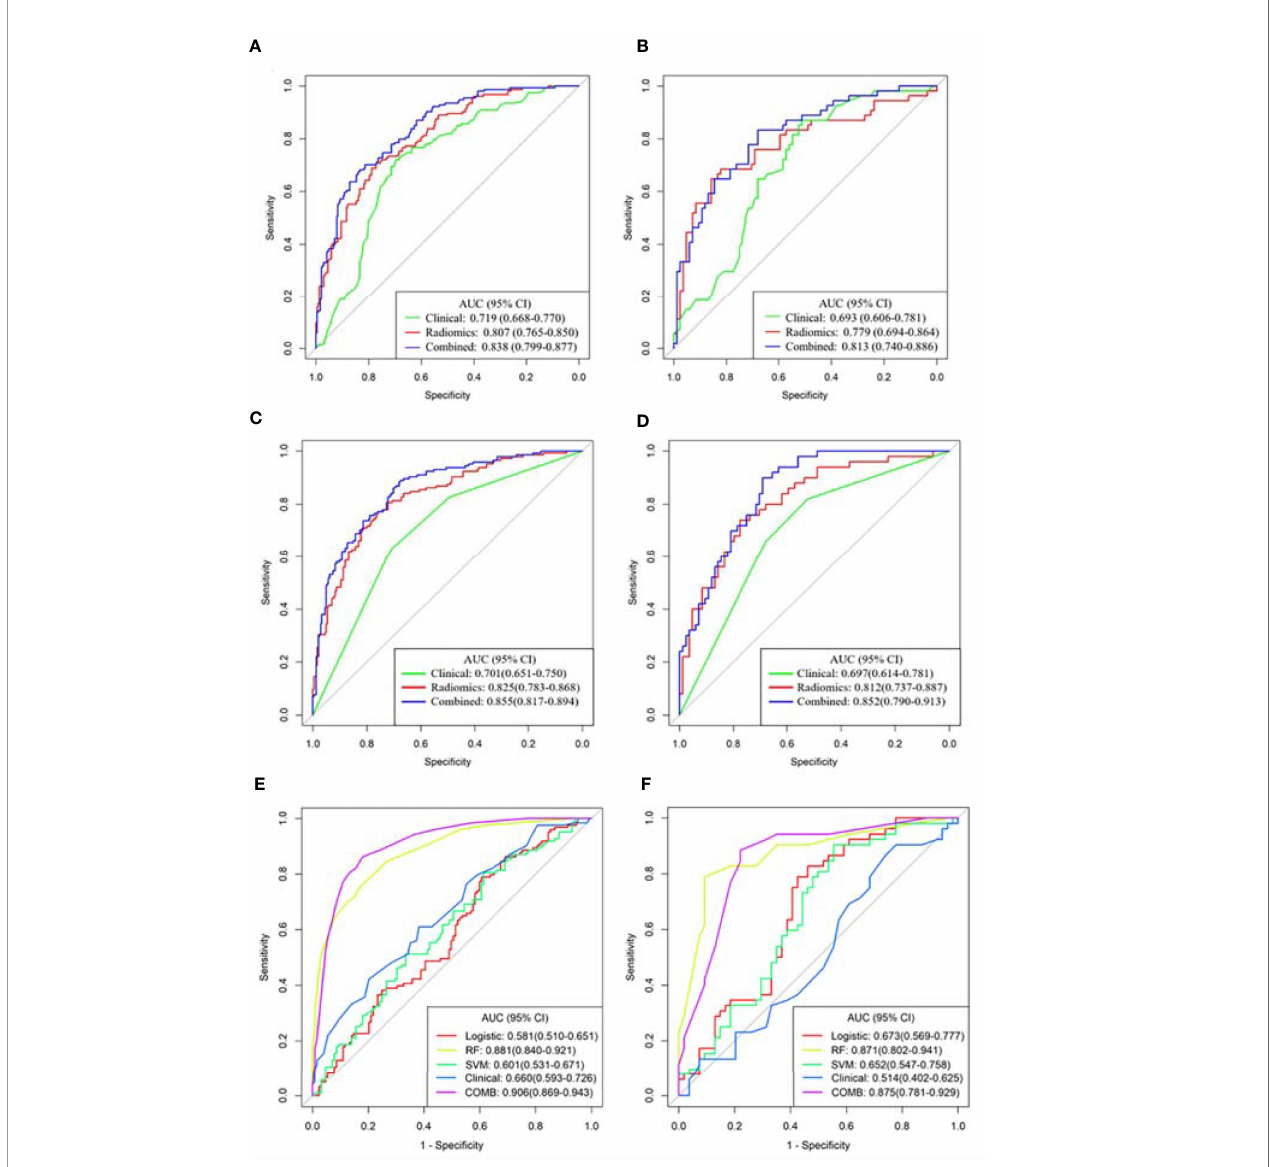
FIGURE 3 | Receiver operating characteristic (ROC) curves of the three models were used to predict the mutant status of EGFR molecular subtypes. (A, B) Del-19 mutation vs . wild-type. (C, D) L858R mutation vs. wild-type. (E, F) Del-19 mutation vs. L858R mutation. (A, C, E) Training set. (B, D, F) Validation